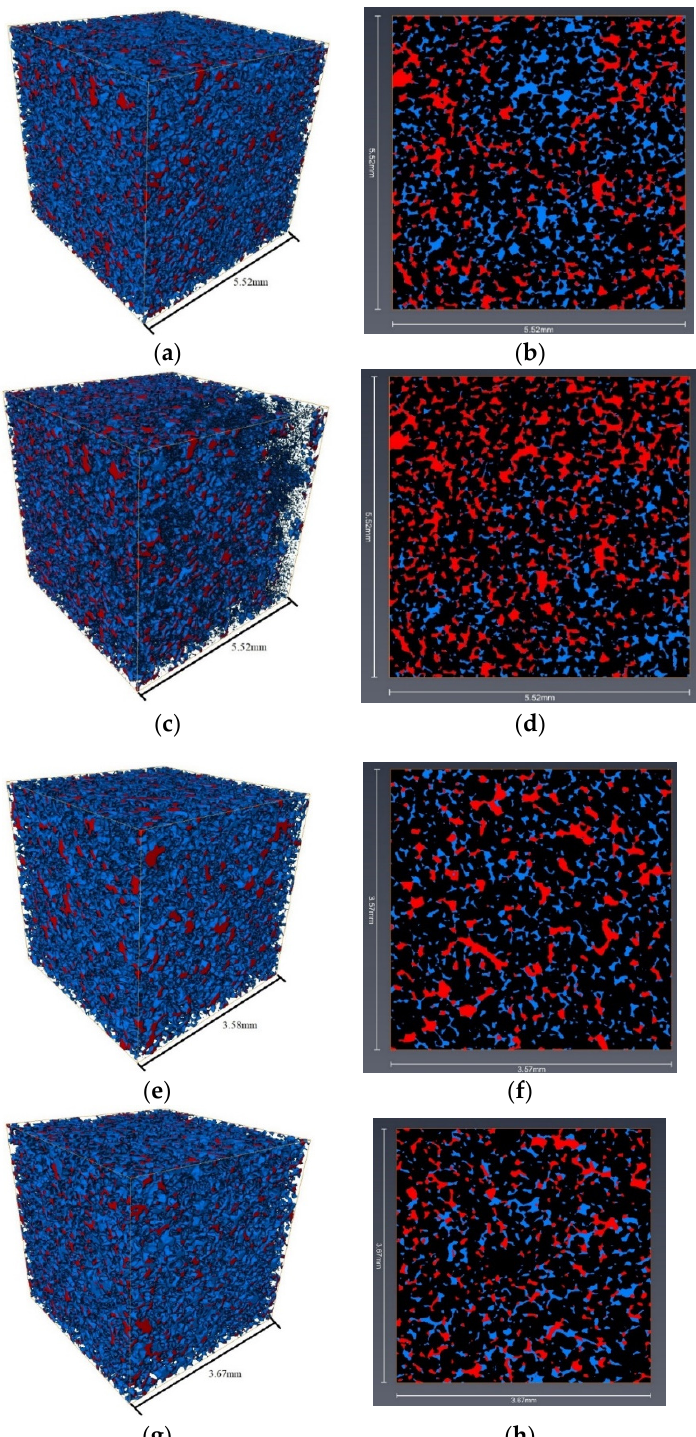
Figure 1. Image datasets of water-wet ( a , b ) and mixed-wet ( c , d ) used for fractal-based calculations (approximately 5.52 mm 3 ) are displayed in three-dimensional datasets and the two-dimensional cross-sectional views In Zou et al. [15]’s work. Image datasets of water-wet ( e , f ) and mixed-wet ( g , h ) used for fractal-based calculations (approximately 3.58 mm 3 ) are displayed in three-dimensional datasets and the two-dimensional cross-sectional views in Lin et al. [42]. The original image datasets are documented in Section 2.1 and then reproduced for visualizations here. All images shown here are steady-state tests at fw = 0.5.